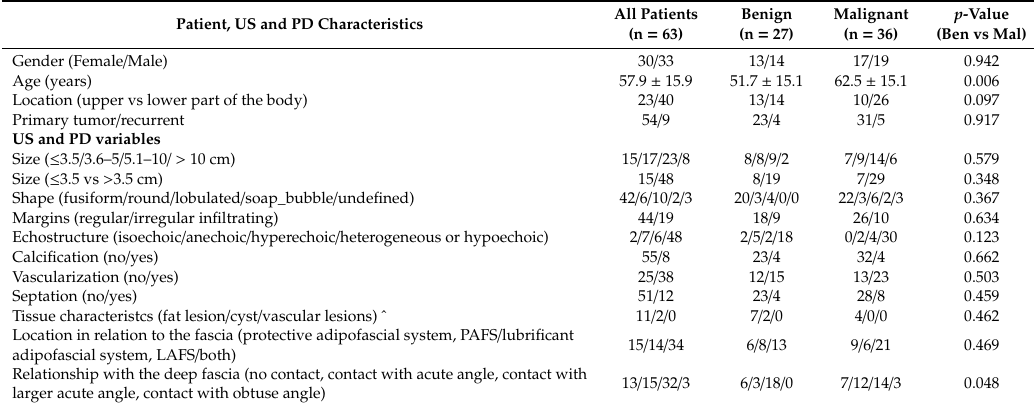
Table 2. Univariate analysis in relation to histological diagnosis of the patients’ data and of ultrasound and power Doppler sonography